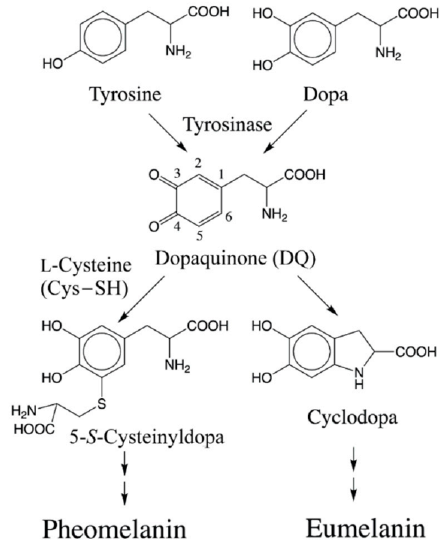
Figure 1. Initial stages of melanin biosynthesis. Tyrosine and its hydroxylated product dopa are converted to dopaquinone (DQ) by the enzyme, tyrosinase. Further reactivity of DQ determines the nature of melanin product formed. Non-enzymatic addition of Cys − SH results in the formation of 5- S -cysteinyldopa (or 2- S -cysteinyldopa) as the major (or minor) product. Oxidative polymerization of cysteinyldopa generates yellow to reddish brown pheomelanin product. On the other hand, intramolecular cyclization of DQ produces cyclodopa which leads to brown to black